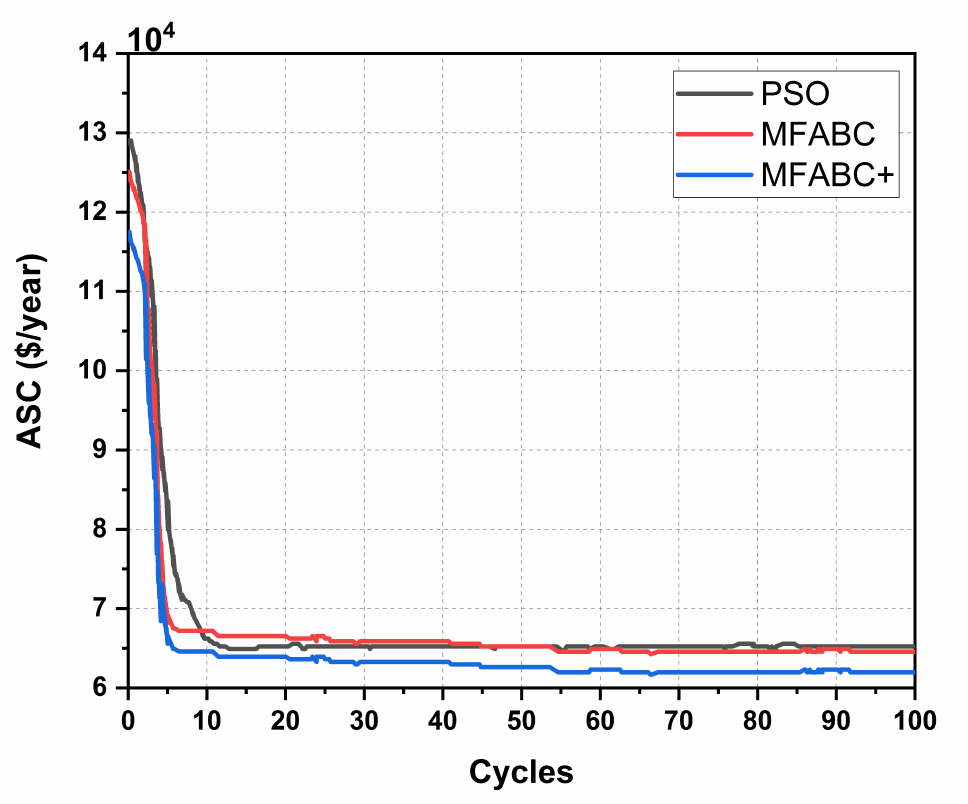
Figure 5. Convergence characteristics of PSO, MFABC and